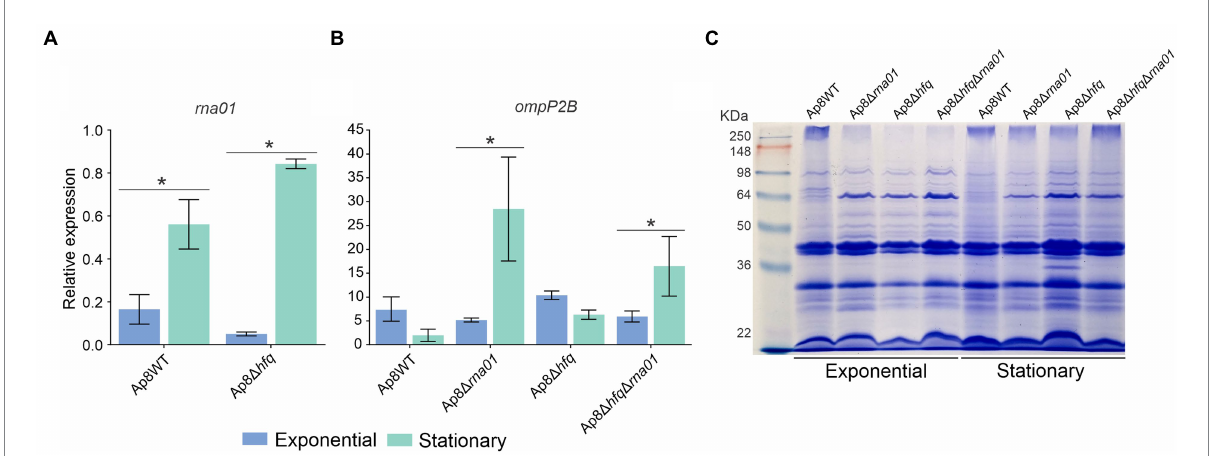
FIGURE 5 rna01 and ompP2B expression and their effect in the outer membrane protein (OMP) contents. qPCR of rna01 . (A) ompP2B (B) during exponential and stationary phases in the WT and mutant strains. (C) OMPs profile of the strains in exponential and stationary phases. *Significative difference by the t -test ( p < 0.1). The experiment was performed in